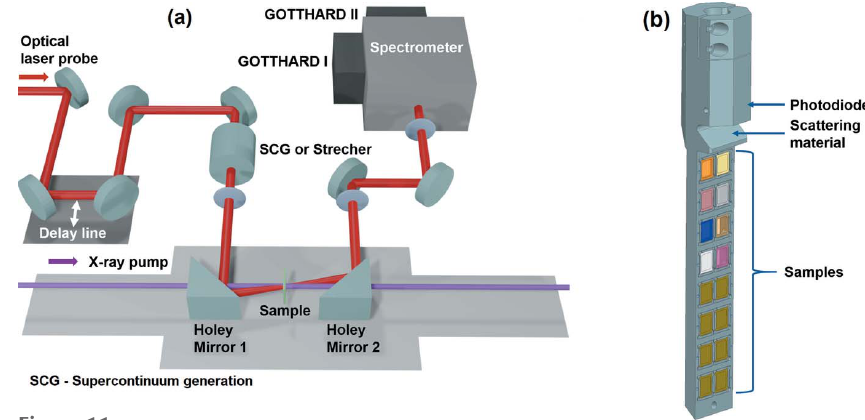
Figure 11 Schematic of ( a ) the PAM setup, and ( b ) the PAM sample holder.